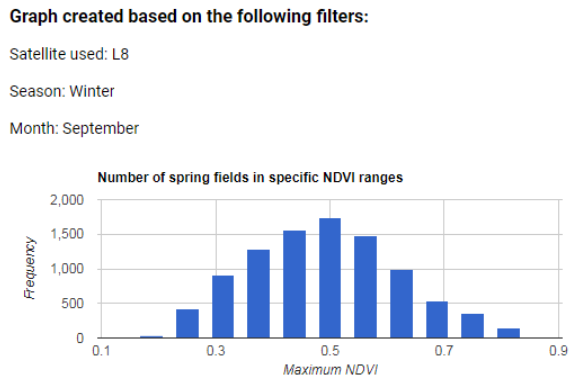
Figure 4. CCROP output histogram showing number of fields versus maximum NDVI for fields planted in September.